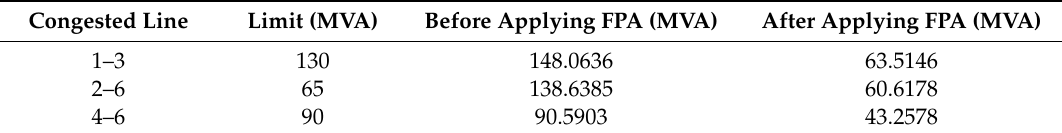
Figure 7. Effect of overload due to an outage. Table 3. Comparison of congested line flow.